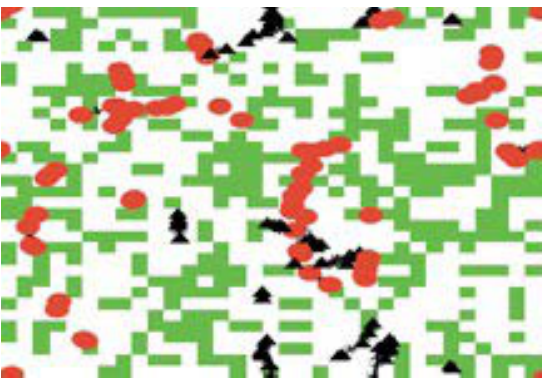
Figure 5. There are no dissatisfied